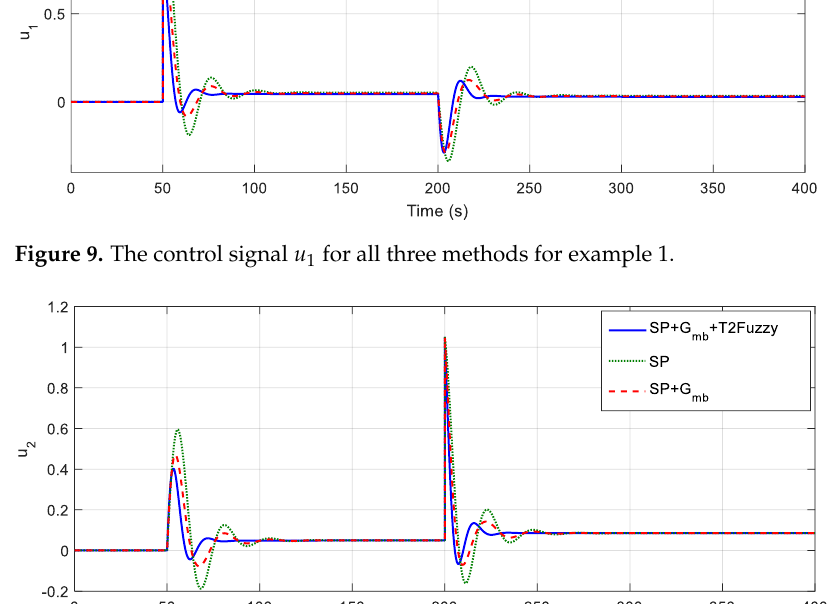
Figure 10. The control signal 𝑢 2 for all three methods for example 1.